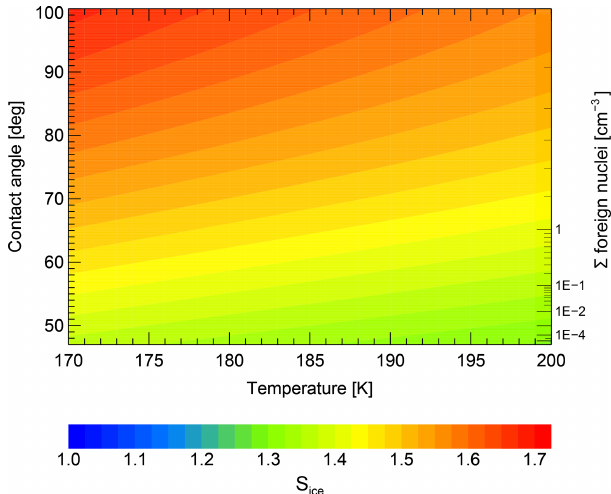
Figure 1. Visualization of the heterogeneous ice nucleation param- eterization derived from Engel et al. (2013). The sum of foreign nuclei initiating heterogeneous ice nucleation (equal to a certain contact angle) resulting from a combination of temperature and su- persaturation